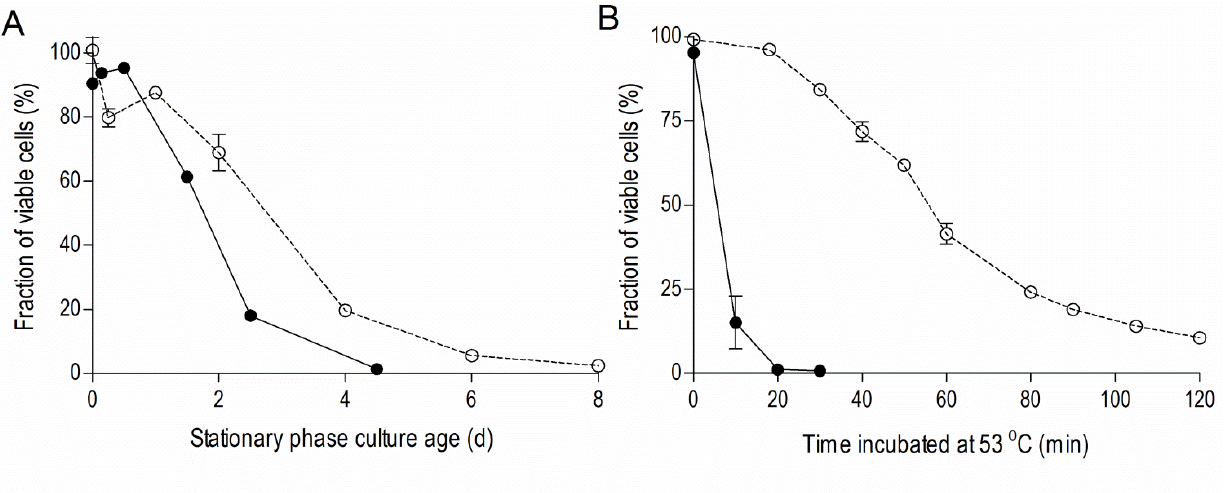
FIGURE 1: Chronological life span and thermotolerance of stationary-phase cultures is much lower under anaerobic than under aerobic conditions. Chronological life span (A) : survival expressed as ratio of colony forming units divided by the number of cells plated, during aerobic and anaerobic SP cultures. Time point zero indicates the onset of SP, which corresponds to exogenous glucose exhaustion in anaerobic cultures and exhaustion of all exogenous carbon sources including ethanol and organic acids in aerobic cultures. Thermotolerance (B) : loss of viability after sudden exposure of cells from aerobic and anaerobic cultures during early SP to 53°C. Open symbols (○) represent aerobic cultures, closed symbols (●) anaerobic cultures. Data represent the average and SEM of measurements on independent duplicate